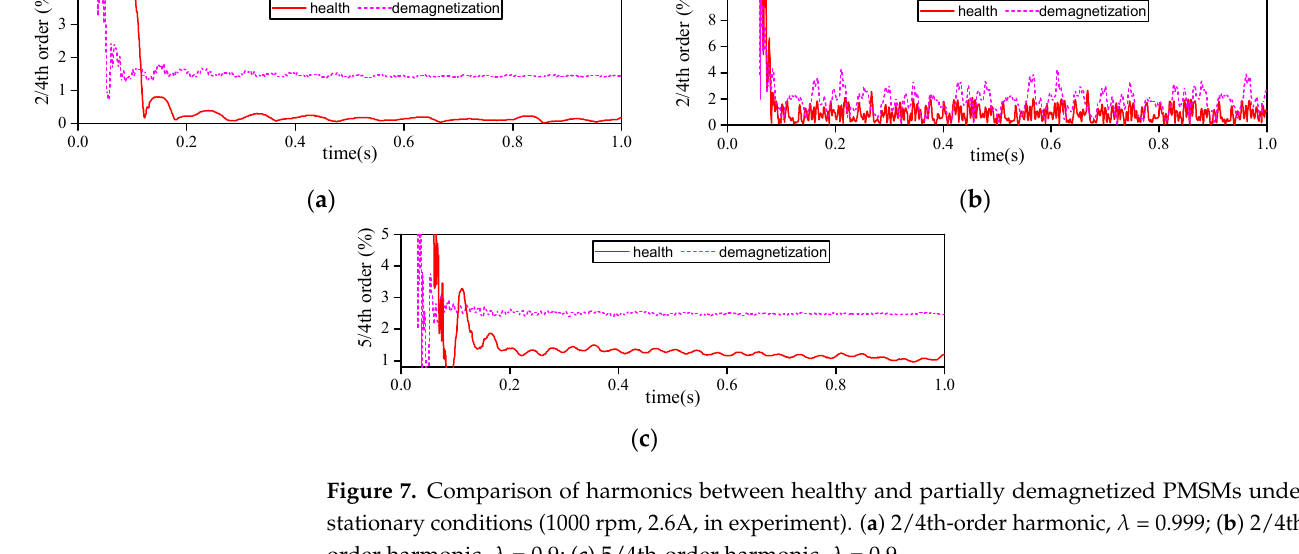
Table 3. Magnitude of each fault-related harmonic component in current with different algorithms and different health status (unit: A).